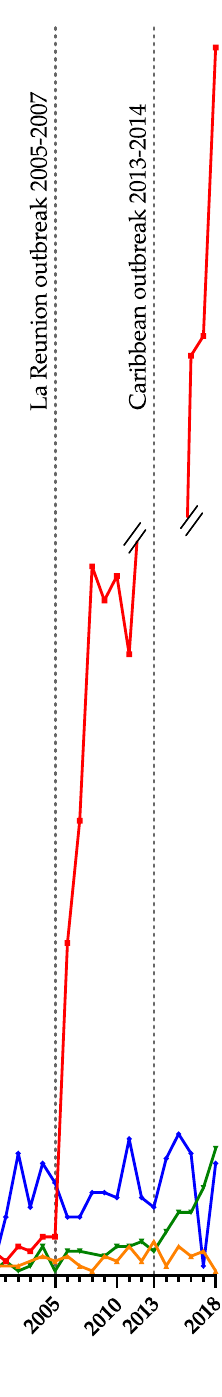
Figure 2. Number of publications for each virus reported in PubMed through the years. CHIKV publications were rare before 2006 (under 10 per year), except during the South-East Asia epidemic in the late 1960s, when it reached around 20 publications per year. Since the La Reunion outbreak, and followed by the Caribbean epidemic, attention has increased tremendously, and publications now number around 500 per year. While Ross River virus has 10–20 publications a year since 1979, MAYV and ONNV had less than 10 publications a year until 2015, and only MAYV has slightly exceeded this number since then.